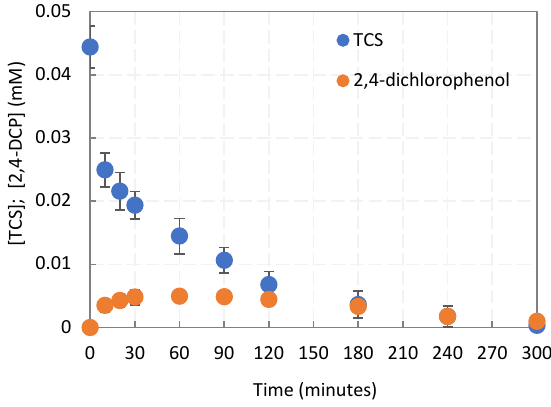
Figure 3. Time course of TCS and 2,4-dichlorophenol (conditions: [TCS] 0 = 10 mg L − 1 , (TiO 2 ) = 1.50 g L − 1 , pH 0 = 5.8).